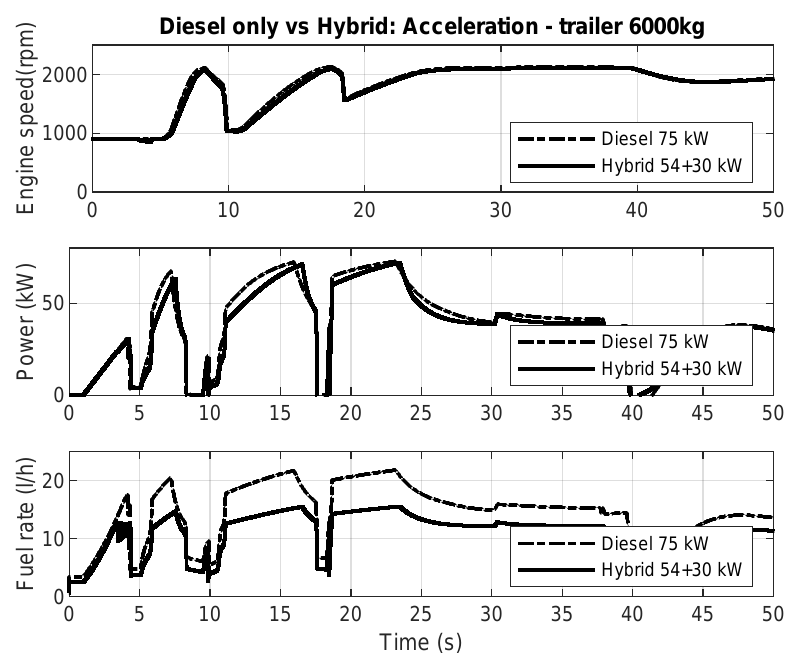
Figure 8. Hybrid vs. traditional architecture: acceleration test with full load